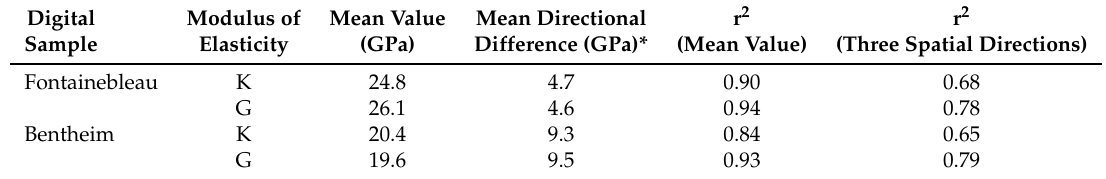
Figure 5. ( a ) The entire microstructure of the Fontainebleau sandstone consists of 24.8 million voxels and is randomly decomposed into 30 sub-cubes (grey) ( b ) comprising 1 million voxels each. Three sub-cubes are identified (blue) being representative for the main microstructure and are further used in our simulations to quantify changes in elastic rock properties due to variations in the calcite volume fraction. Table 2. Bulk (K) and shear (G) moduli of both digital sandstone samples and their correlation to porosity considering all